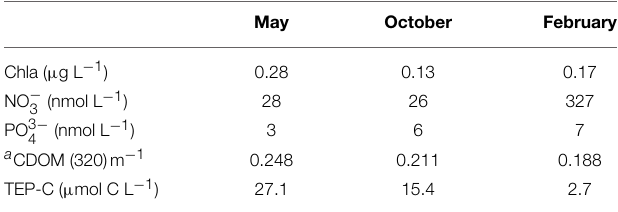
TABLE 1 | Initial conditions (unfiltered water: chlorophyll a, TEP-C; filtered water: nitrate, phosphate) for the three minicosm experiments in May, October and February ( in situ values at 5-m